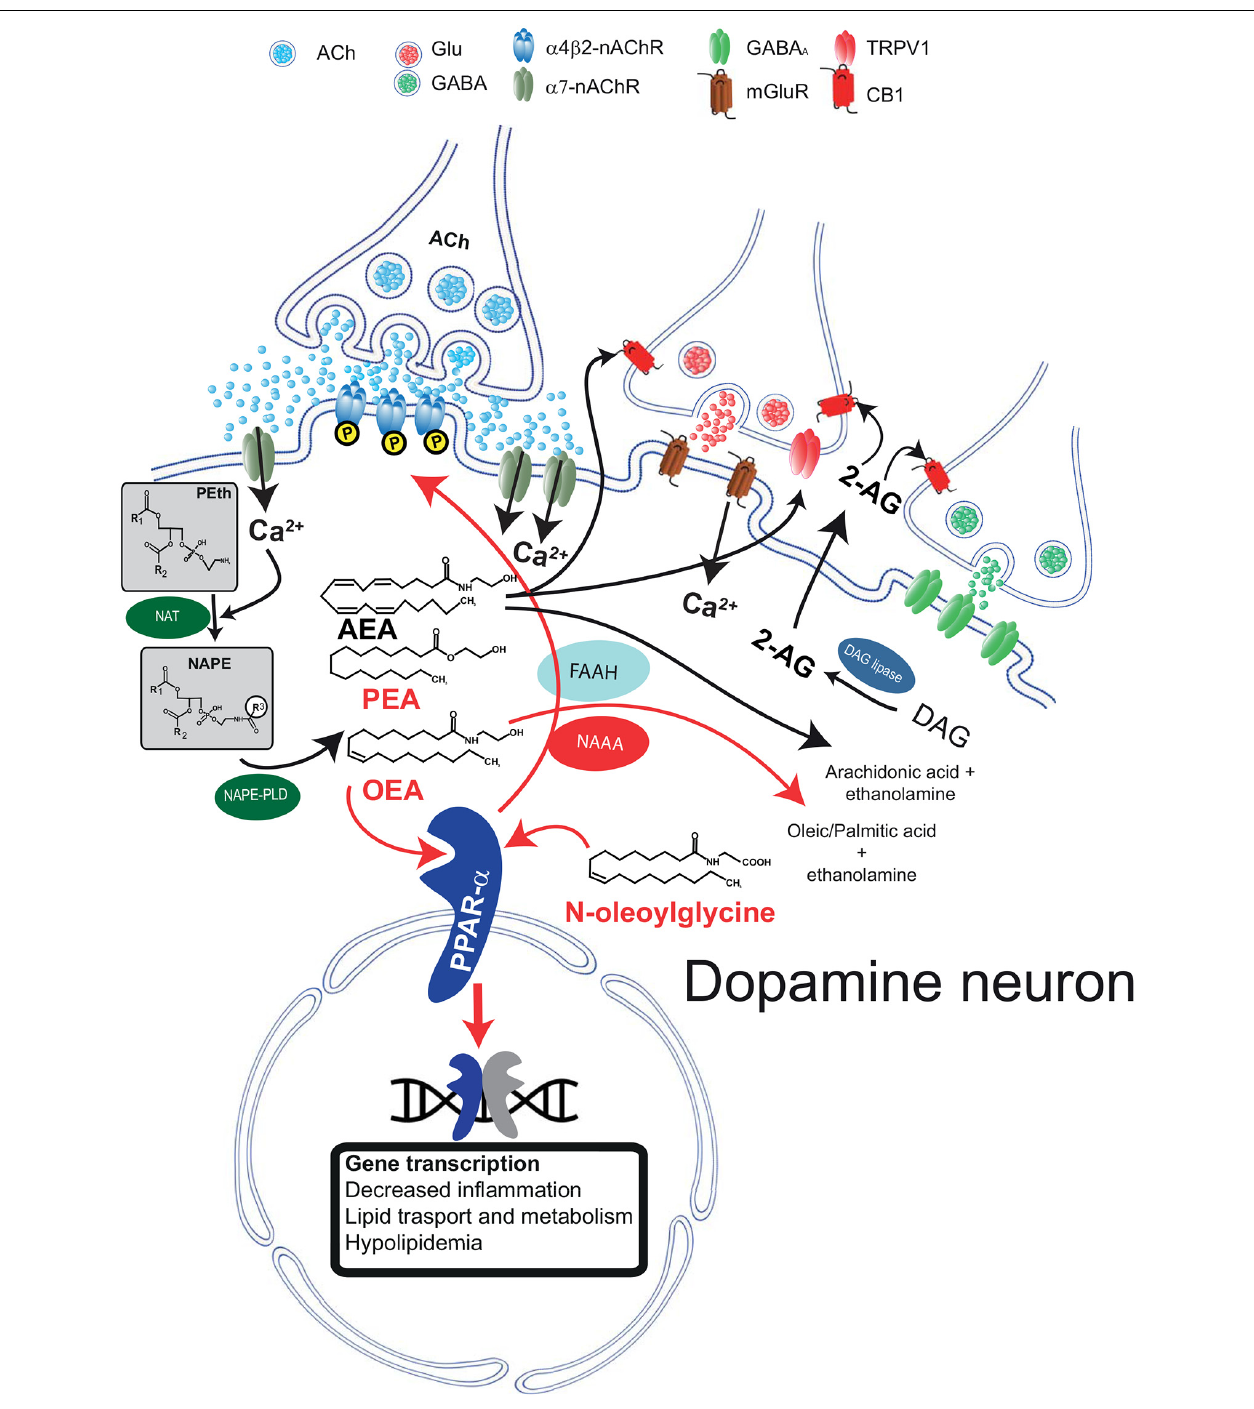
FIGURE 1 | Schematic diagram illustrating the biosynthetic and catabolic pathways for N- acylethanolamine (NAE) and canonical endocannabinoid formation and catabolism, and their cellular mechanisms of actions through their receptors. Phosphatidylethanolamine (Peth) is converted into N- acyl-phosphatidylethanolamine (NAPE) by N- acyltransferase (NAT). Ca 2+ entry mediated by α 7-nAChRs activates NAEs synthesis through the Ca 2+ dependent NAT. The resulting NAPE is hydrolyzed by NAPE-PLD to the corresponding NAEs anandamide (AEA), oleoyl ethanolamide (OEA), and palmitoylethanolamide (PEA). Activation of PPAR α by NAEs results in genomic effects (gene transcription) and in non-genomic actions, such as activation of a tyrosine kinase and phosphorylation of β 2 ∗ nAChRs (i.e., α 4 β 2). Fatty acid amide hydrolase (FAAH) and NAE-hydrolyzing acid amidase (NAAA) are the major inactivating enzymes for OEA, PEA, and AEA and convert them in ethanolamine and corresponding fatty acids (oleic, palmitic, and arachidonic acids, respectively). NAAA preferentially hydrolyzes PEA. N- oleoyl glycine is one